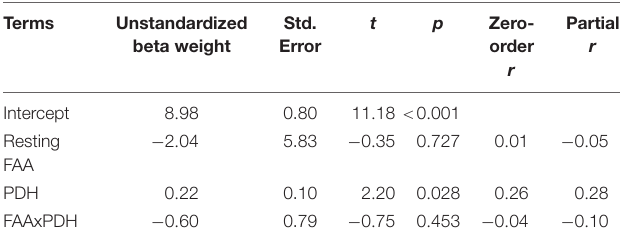
TABLE 3 | Parenting daily hassles and resting EEG as predictors of externalizing